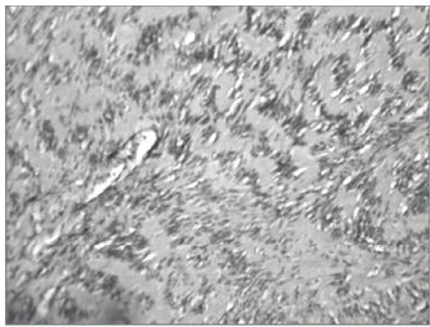
Figure7:Histopathologyslideofthesurgicalspecimenisconsistent with diagnosis of Antoni A schwannoma.